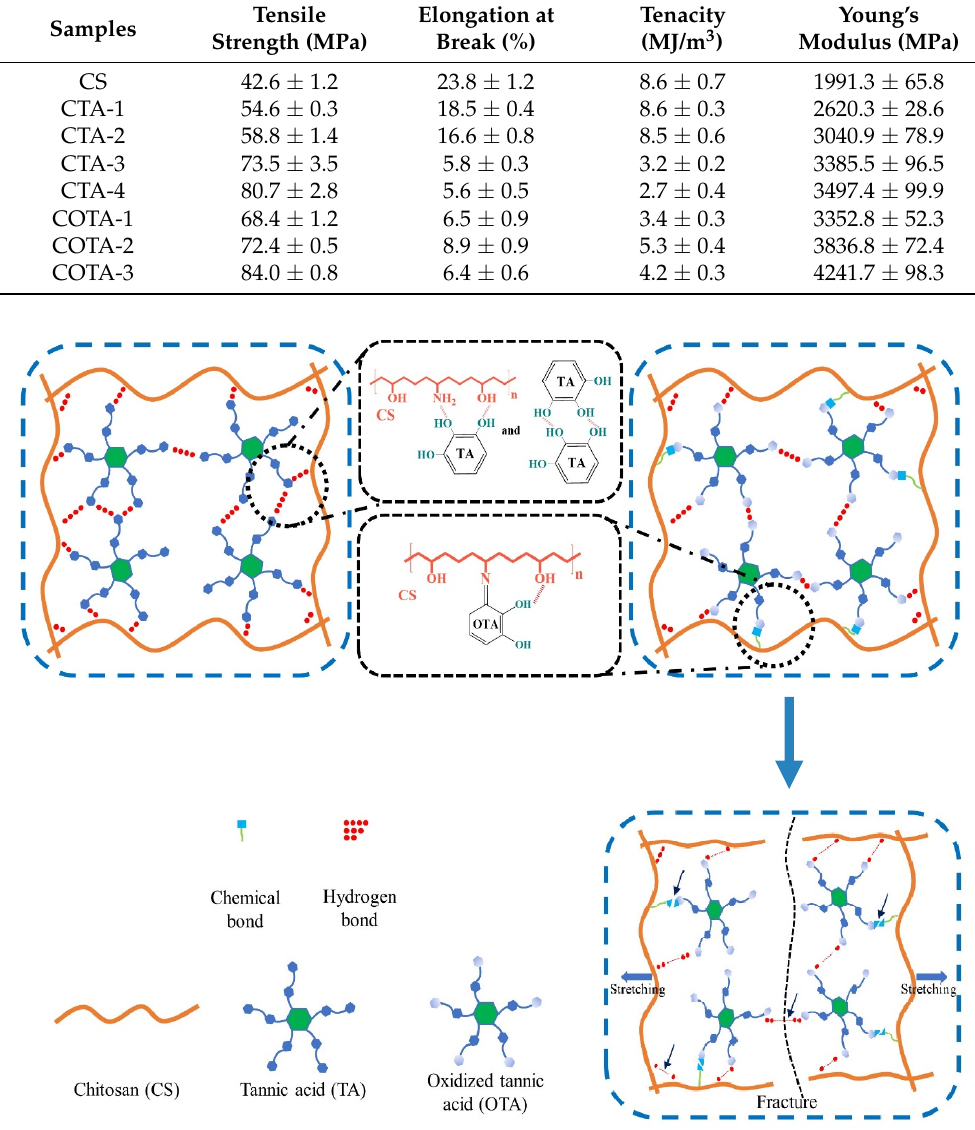
Scheme 1. Schematic diagram of the internal structure of CTA and COTA films.